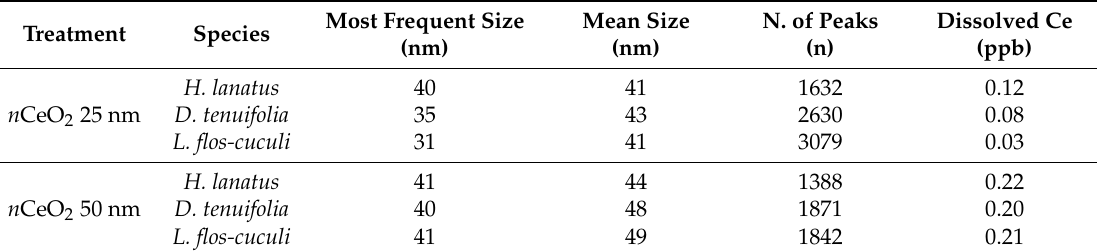
Table 2. Most frequent size, mean size and number of peaks determined by sp–ICP–MS analysis after enzyme treatment of seedlings of H. lanatus , L. flos-cuculi and D. tenuifolia treated with 20 mg L − 1 of n CeO 2 25 nm and 50 nm.